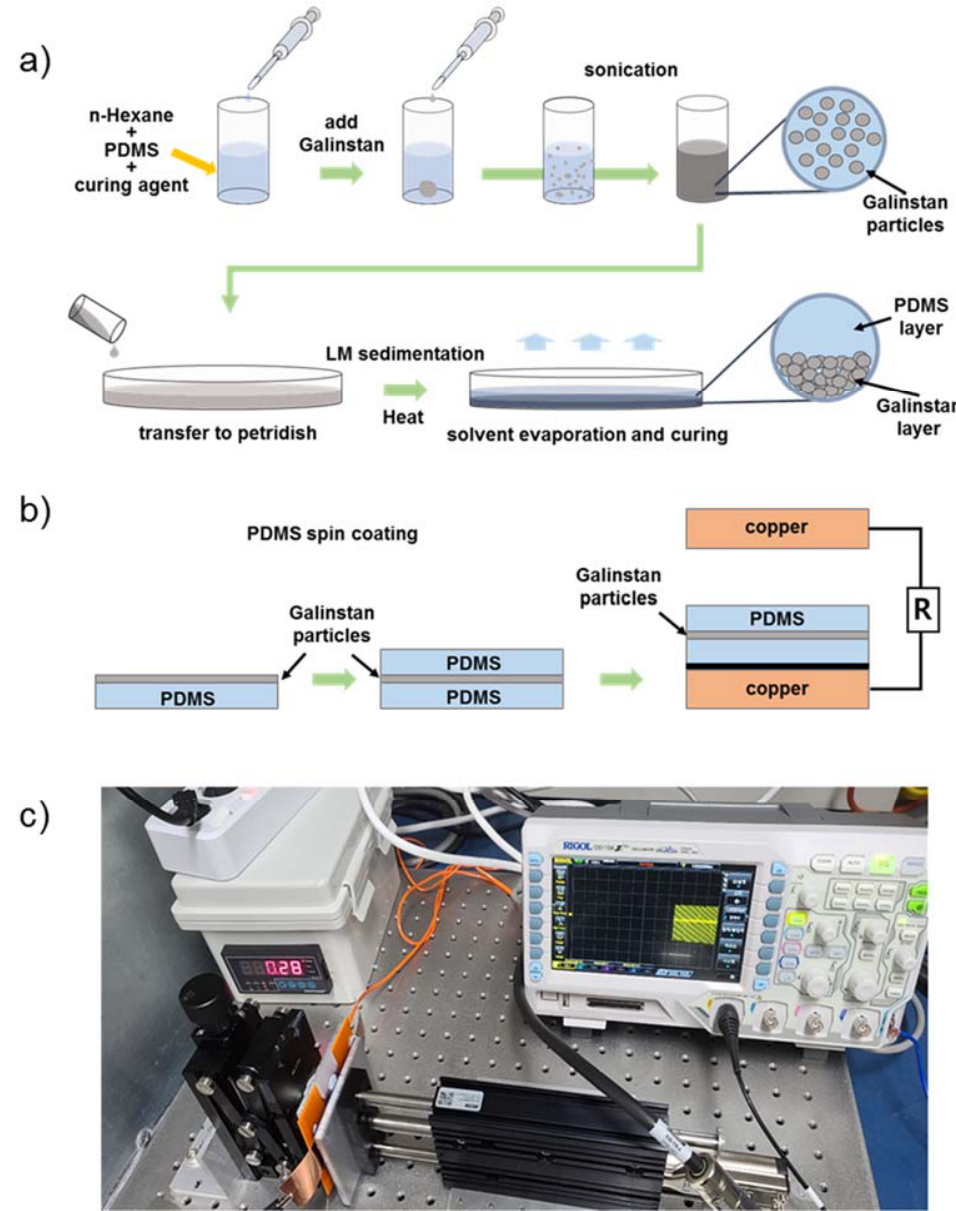
Figure 1. ( a ) Schematic illustration of the fabrication process of a TENG component using Galinstan particle layers. ( b ) Structure of a TENG with Galinstan particle layers inserted. ( c ) The experimental setup used to measure the TENG’s performance.